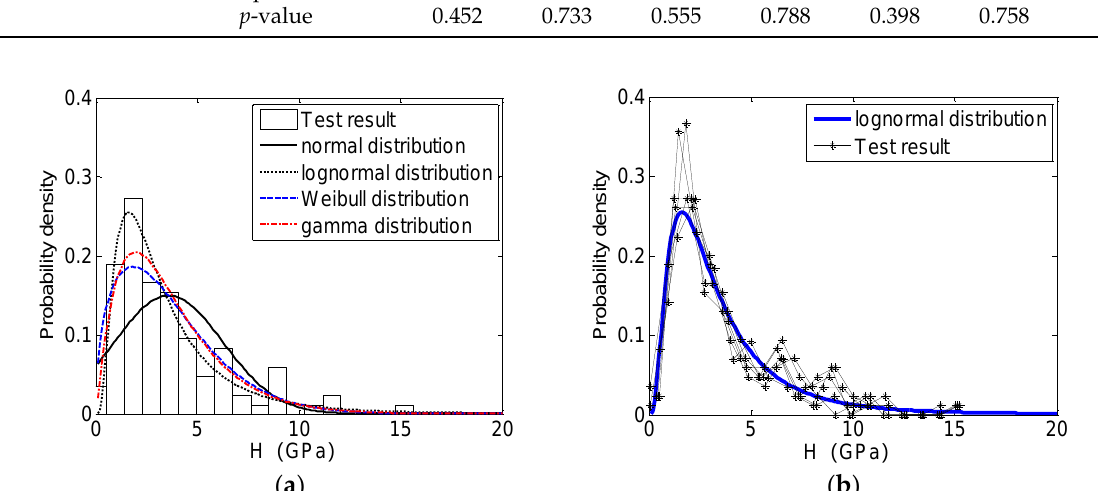
Figure 5. Frequency plots for indentation hardness of the bulk paste: ( a ) histogram of one point out of six and 4 theoretical PDF curves; ( b ) frequency plots of 6 points and the theoretical PDF curve with best estimates.